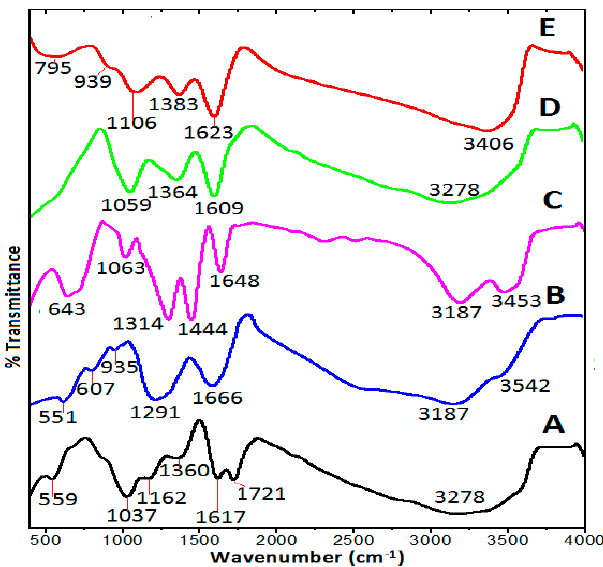
Figure 4. FTIR spectra of GO nanosheets (A); pure protocatechuic acid (B); pure Gd(NO 3 ) 3 (C) protocatechuic acid loaded on GO/Gd nanolayers (GAGPA) (D); and gold nanoparticles coated on GAGPA nanocomposite (GAGPAu) (E).